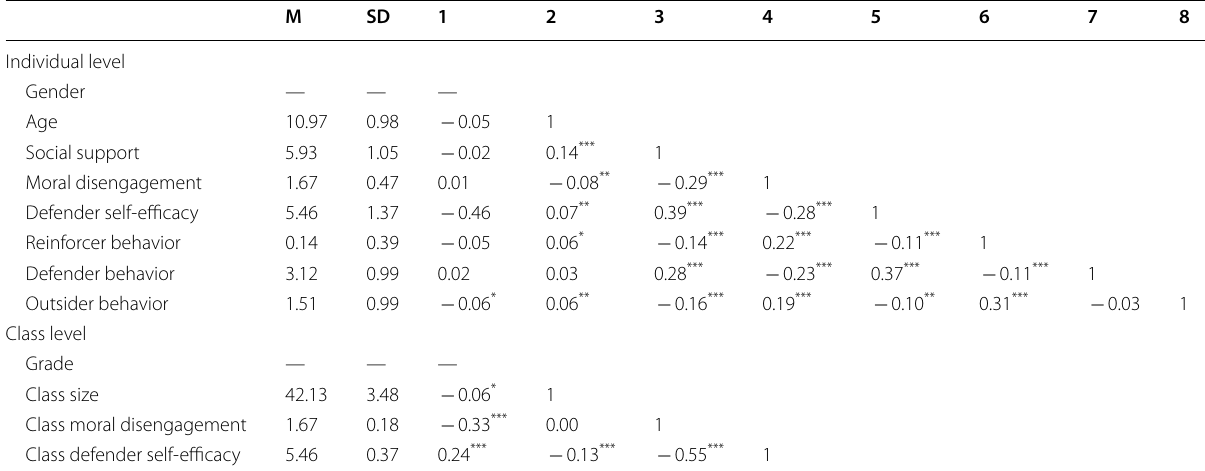
Table 1 Descriptive statistics and correlations among the variables